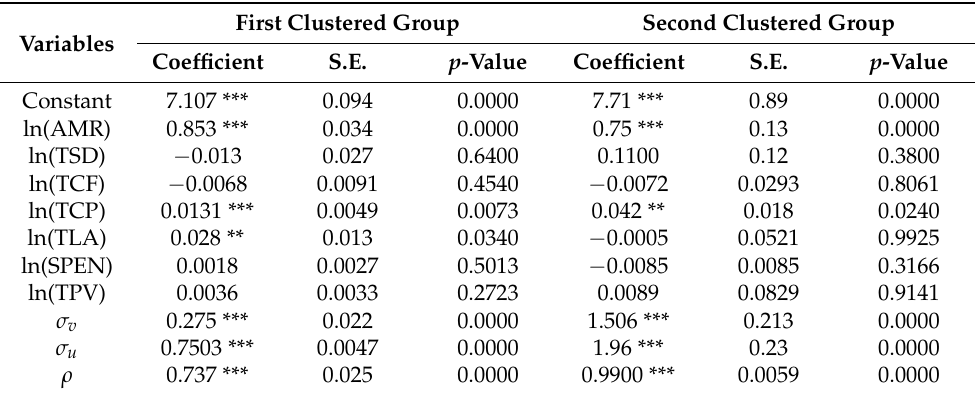
Table 4. Estimates for parameters of stochastic frontier models for major rice farmers in the upper north of